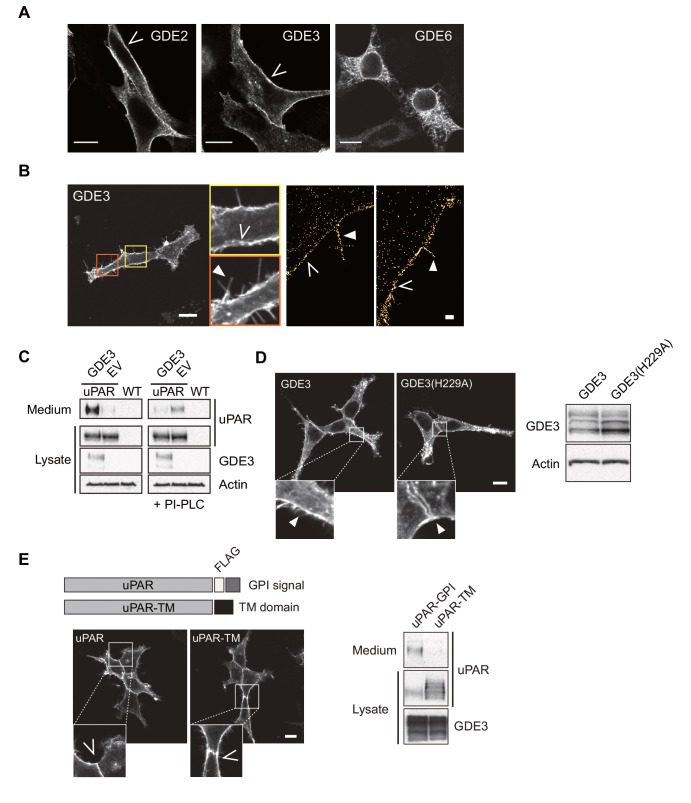
GDE subcellular localization and induction of uPAR release from HEK293-uPAR cells.(A) Confocal images of HEK293 cells expressing human GDE2-HA, GDE3-HA or GDE6-HA, as indicated; bar, 10 μm. (B) GDE3 localizes to distinct microdomains (yellow square, open arrows) and filopodia-like extensions (orange square, solid arrow), as visualized by confocal and super-resolution microscopy. Bars, 10 μm and 1 μm respectively. (C) Immunoblot analysis showing that GDE3 reduces the membrane-anchored uPAR pool and competes with PI-PLC. The medium and lysates of HEK-uPAR cells expressing GDE3 or empty vector (EV) were analyzed without or with PI-PLC treatment (45 min.) of the cells, as indicated (left and right panels, respectively). Right lanes refer to wild-type (WT) HEK293 cells. (D) Expression and localization of GDE3 and mutant GDE3(H229A), as measured by immunoblotting and confocal microscopy, respectively, at 24 hr after transfection. Actin was used as a loading control. (E) uPAR-TM containing the transmembrane domain of EGFR is not released by GDE3, as shown by immunoblotting using anti-uPAR antibody, while uPAR-TM is properly expressed at the plasma membrane (bar, 10 μm).